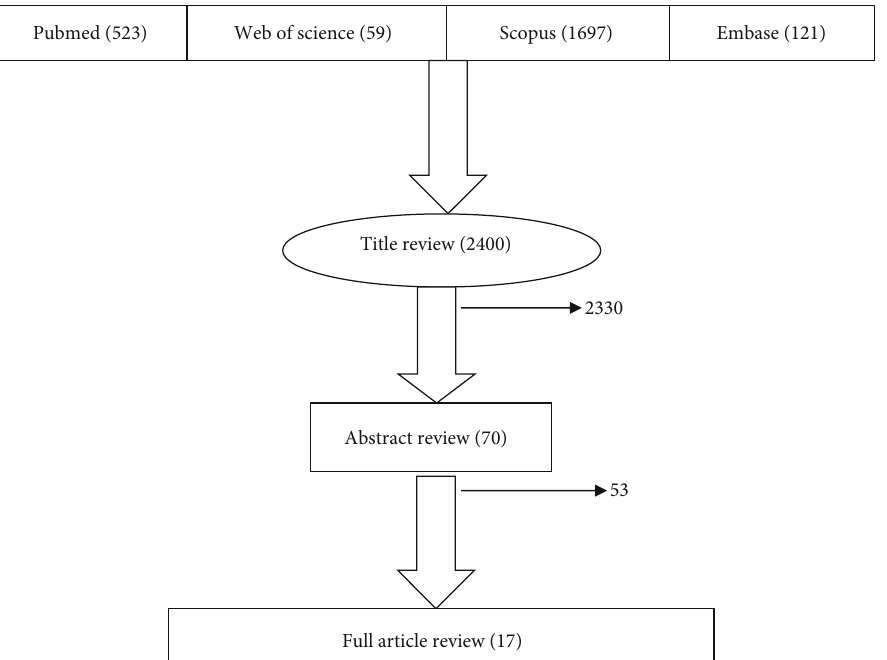
Figure 1: Article screening stages: PRISMA (Preferred Reporting Items for Systematic Review and Meta-Analyses) fl owchart diagram of the record selection